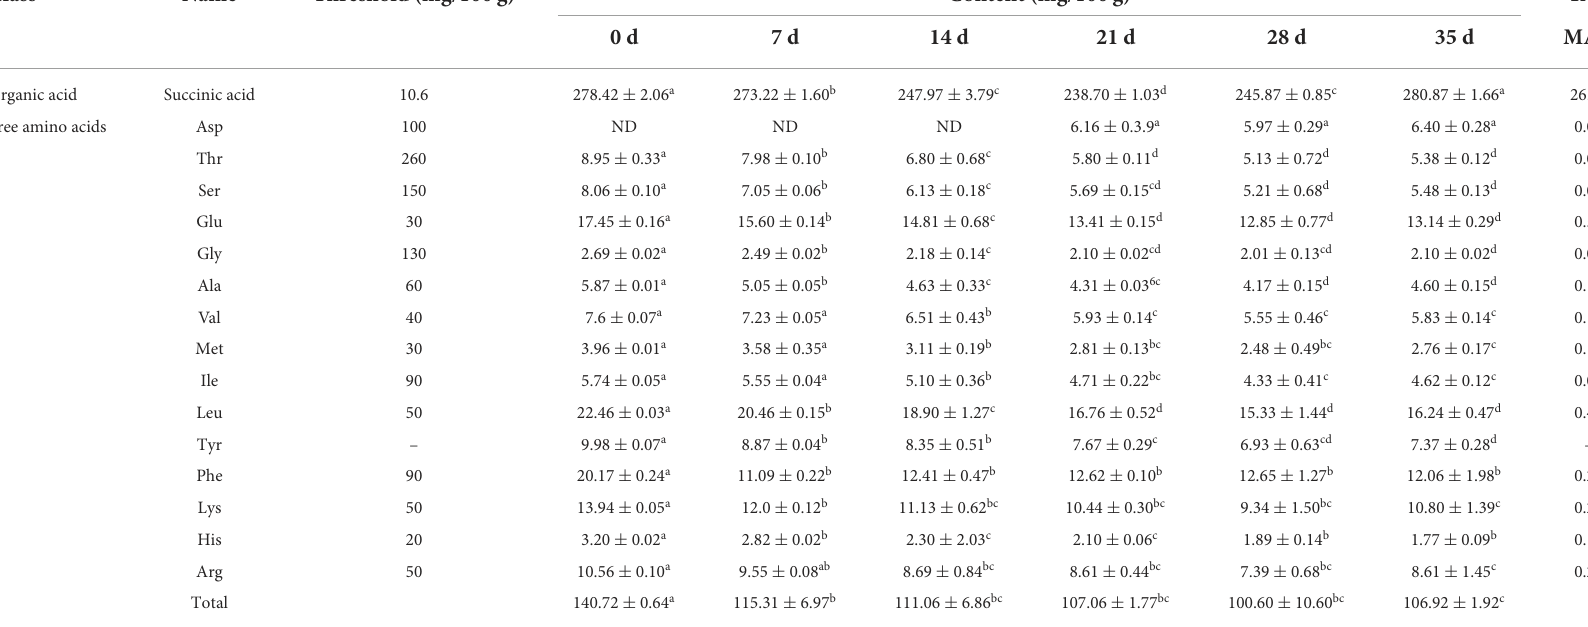
TABLE 2 The contents of succinic acid and free amino acid in preserved egg yolk during